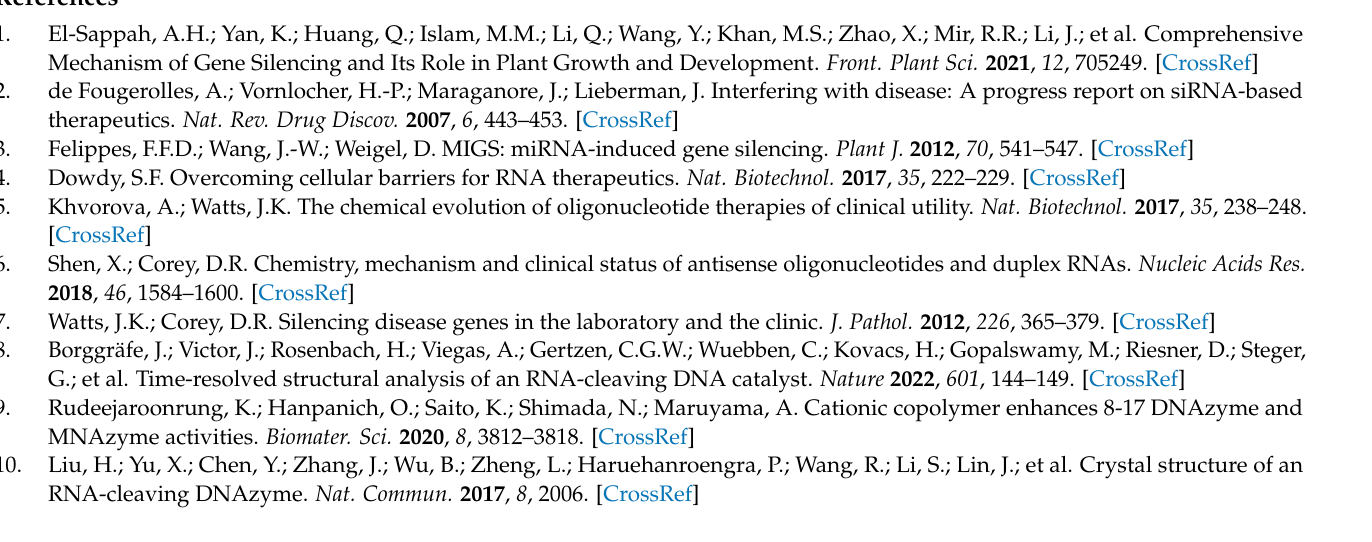
Table S1: The sequences of short RNA substrates; Table S2: The sequences of Dz04, Dz4M, Dz4S and mismatched controls; Table S3: The sequences of Dz04 and Scr control with different modifications at both arms; Table S4: Dz04 sequences with various number of PS linkages on each arm. Author Contributions: Conceptualization, Z.H. and Z.Z.; methodology, Z.Z.; software, Z.Z.;